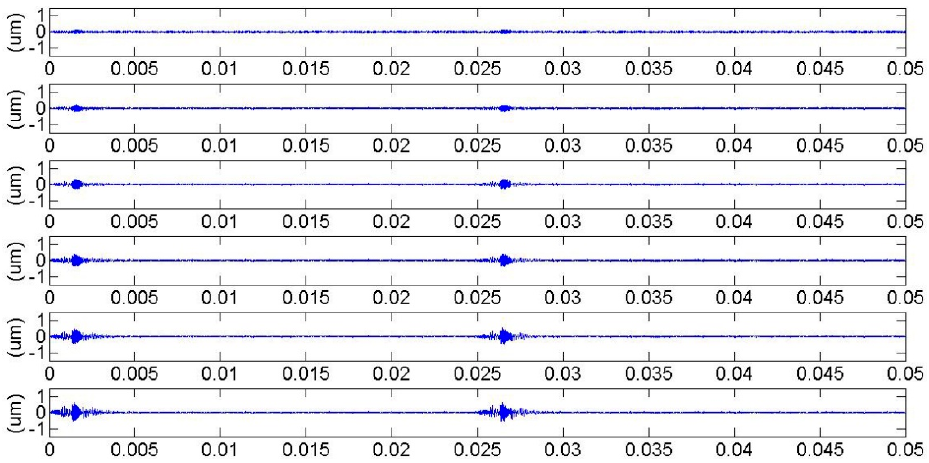
Figure 26. Vibration response of cracked gear at gear number 20/20.